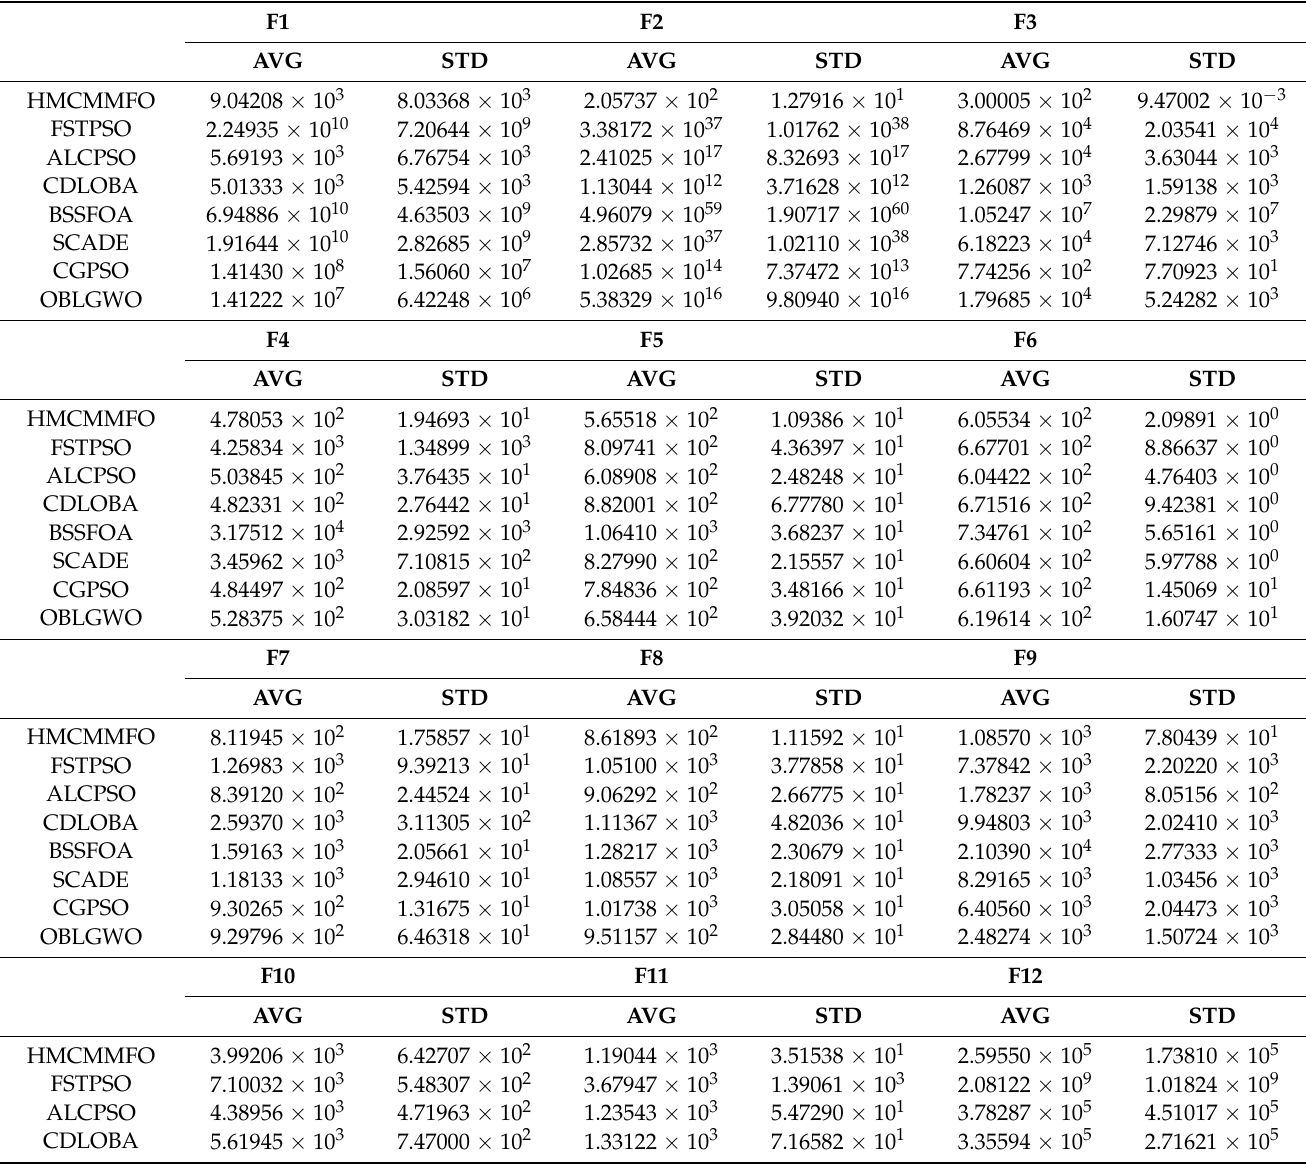
Table 8. Comparison results of advanced